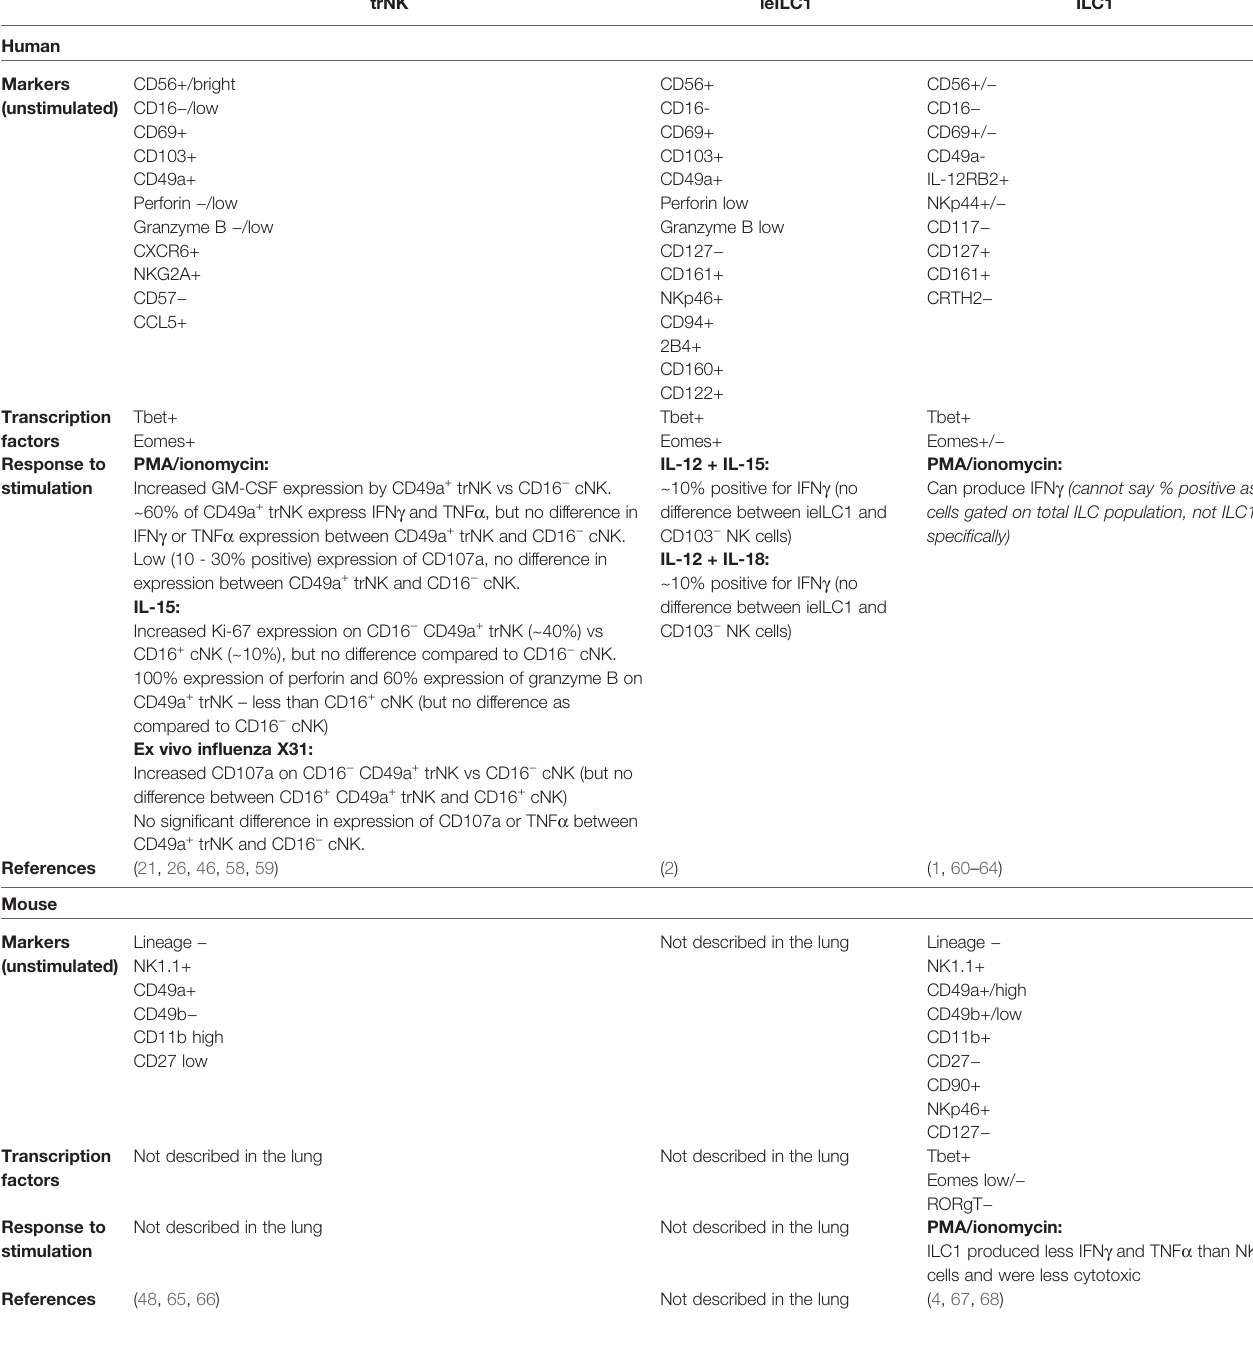
TABLE 1 | Characteristics of trNK cells, ieILC1s and ILC1s in the human and mouse lung. trNK ieILC1